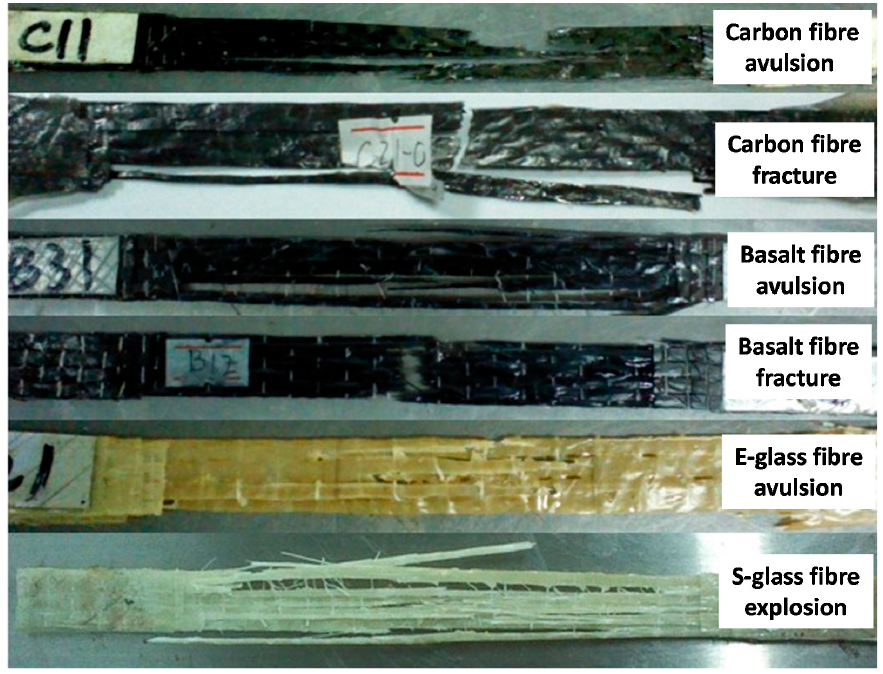
Figure 6. Typical failure situation of different FRP sheet specimens.